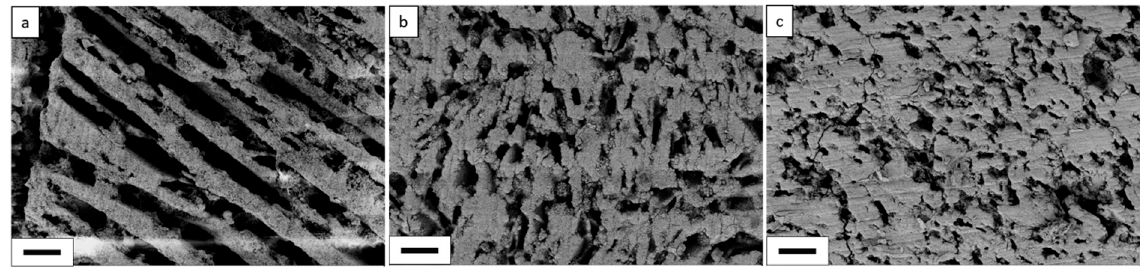
Figure 2. SEM images of specimens cross-sections perpendicular to freezing direction, frozen with 2 K / min cooling rate and di ff erent solid content: ( a ) 40 wt%; ( b ) 50 wt%; ( c ) 60 wt% (the scale bar is 100 µ m).